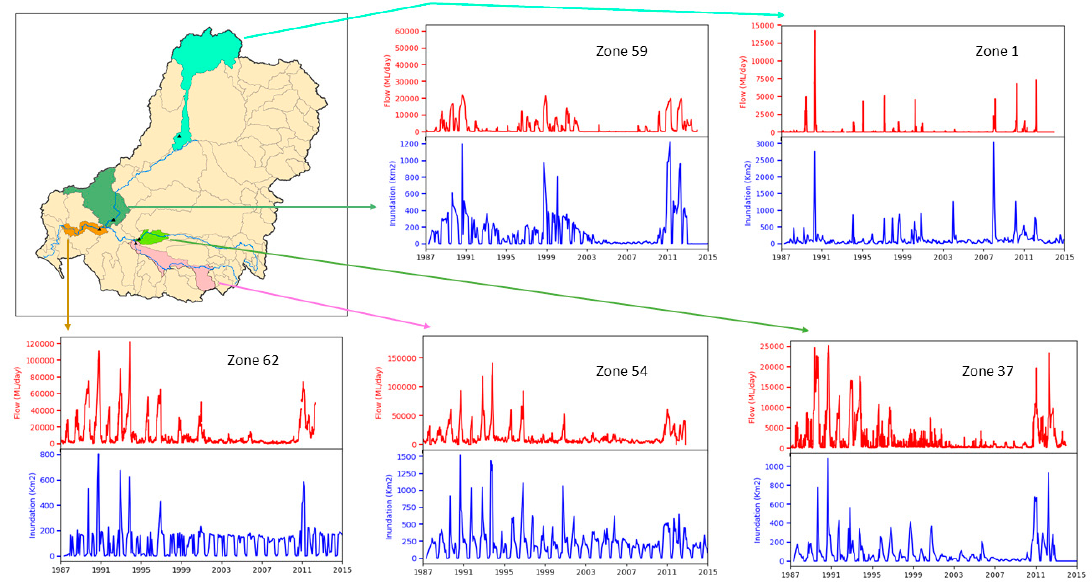
Figure 7. Time series flow magnitude and remotely sensed inundation area for 5 demonstration zones.